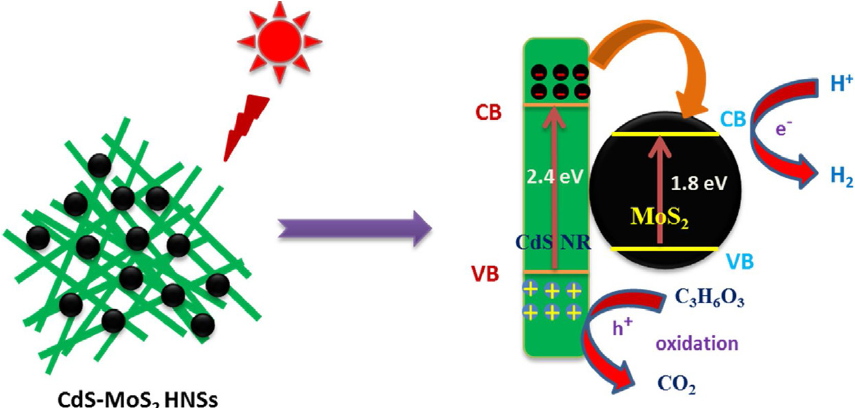
Figure 23. Schematic illustration of the proposed mechanism for enhanced photocatalytic activity during H 2 evolution. Copyrights 2018 Elsevier [182].